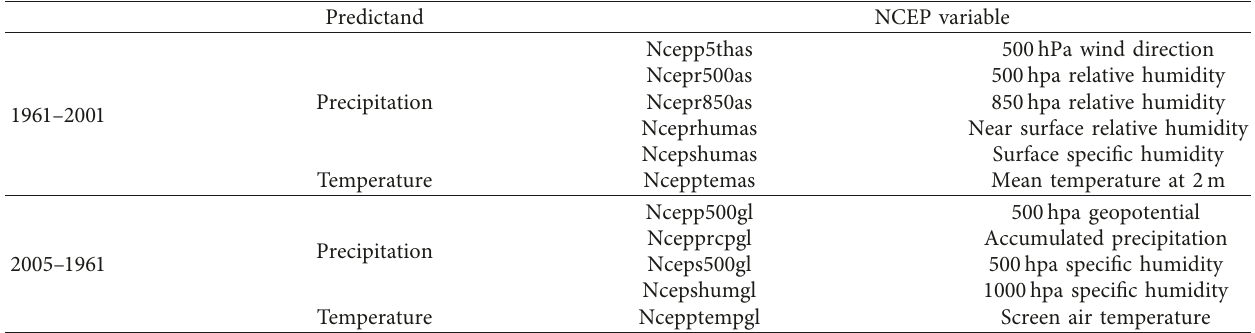
Table 4: NCEP variables for two periods (1961–2001 and 1961–2005).